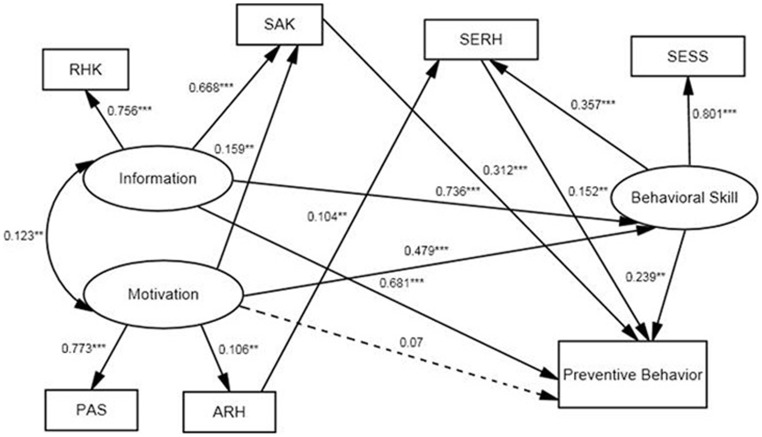
The final IMB model predicting preventive behavior among 944 unmarried rural-to-urban female migrants.Oval represent multiple-indicator latent variables, rectangle represent single-indicator observable variables. Single-headed arrow represent regression path, double-headed arrows represent correlations. Regression coefficients are standardized (** p<0.01, *** p<0.001). Dotted line indicates non-significant path from original IMB.